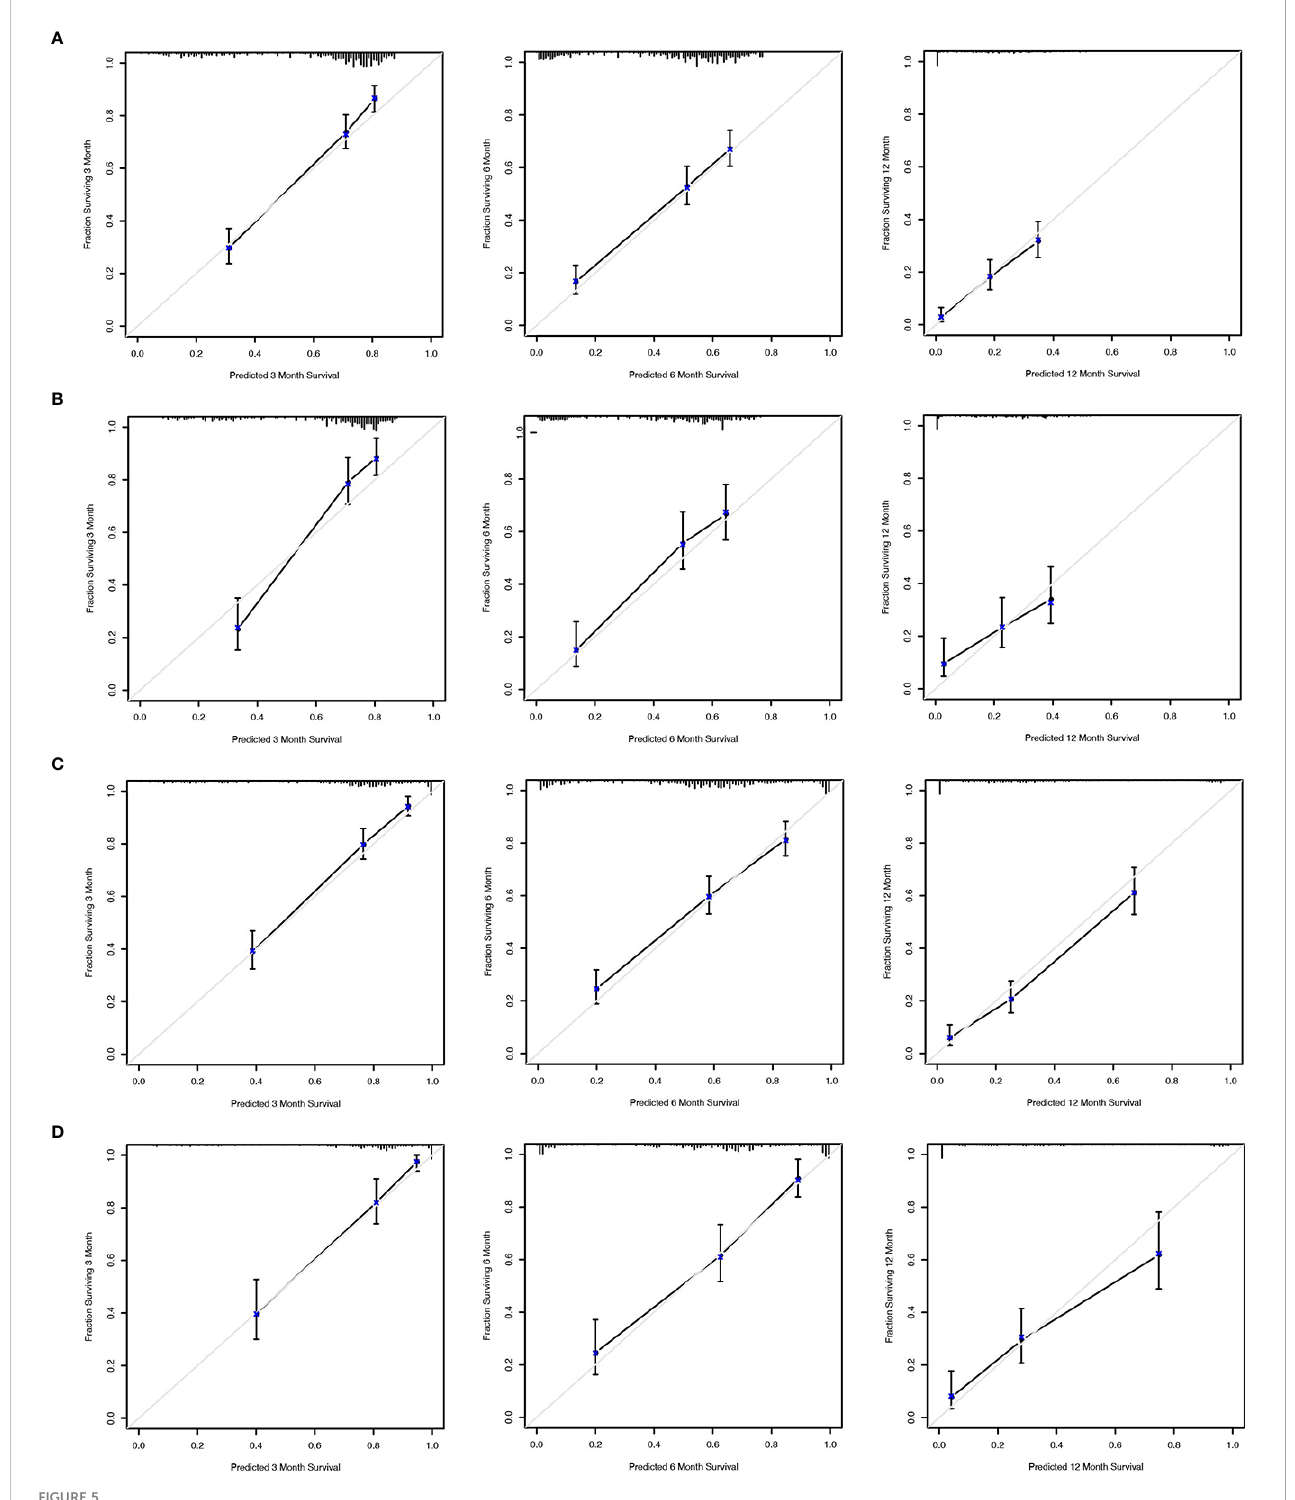
FIGURE 5 Calibration curves to predict 3-month, 6-month and 12-month overall survival of SCLC patients with BM in the training cohort (A) and validation cohort (B) . Calibration curves to predict cancer-speci fi c survival in SCLC patients with BM in the training cohort (C) and validation cohort (D)